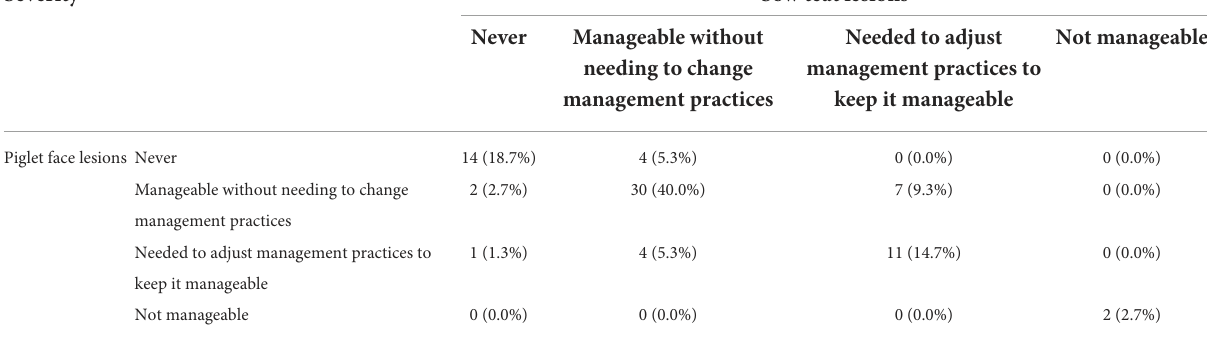
TABLE 3 Correlation between the reported severity of piglet face and sow udder lesions [Spearman’s rank correlation (r s ) = 0.727, P < 0.001]. Severity Sow teat lesions